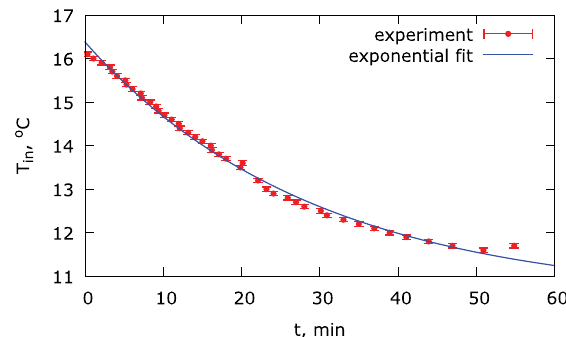
Fig. 9. Results of our fi rst experiment (red dots) ant the least- square exponential fi t (blue